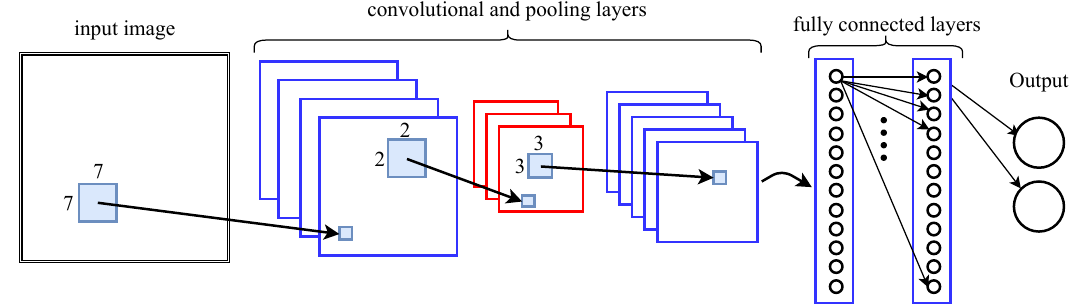
Figure 3. Principle architecture of a convolutional neural network